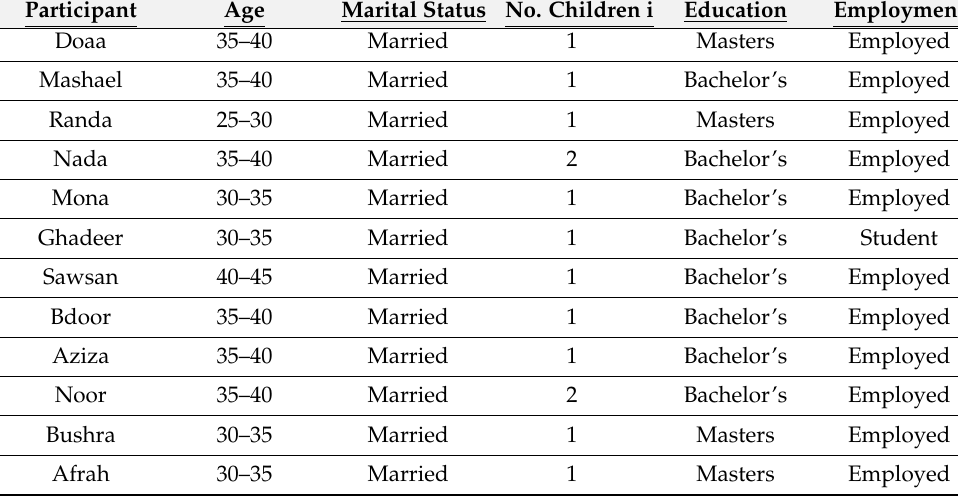
Table 1. Characteristics of the